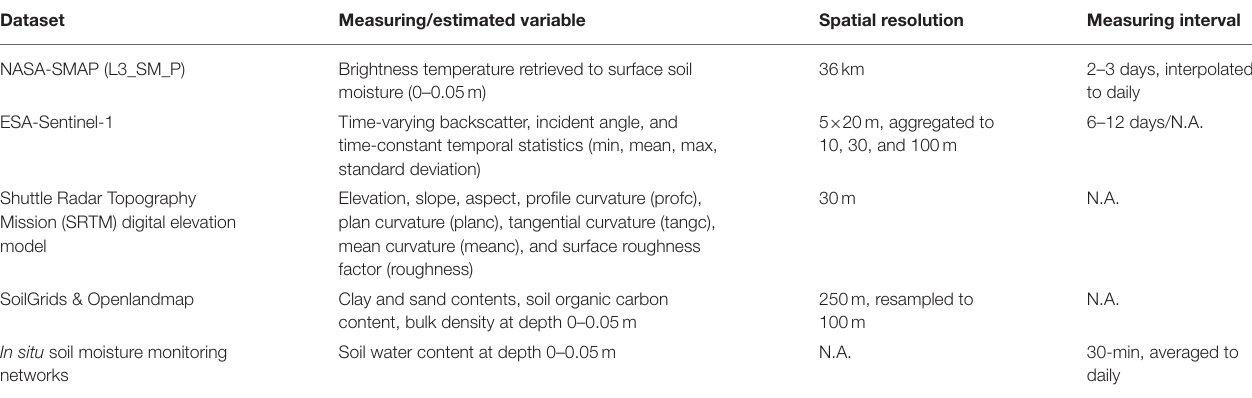
TABLE 2 | Remote sensing and land surface datasets used for modeling surface soil moisture